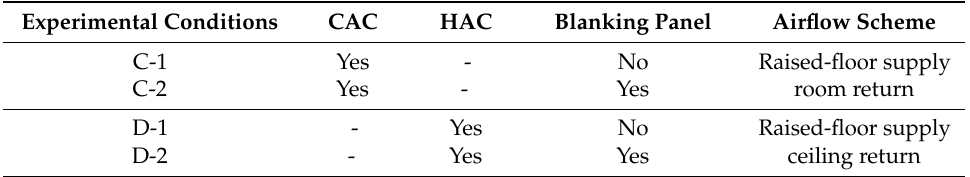
Table 6. Experimental conditions (experiments C and D).